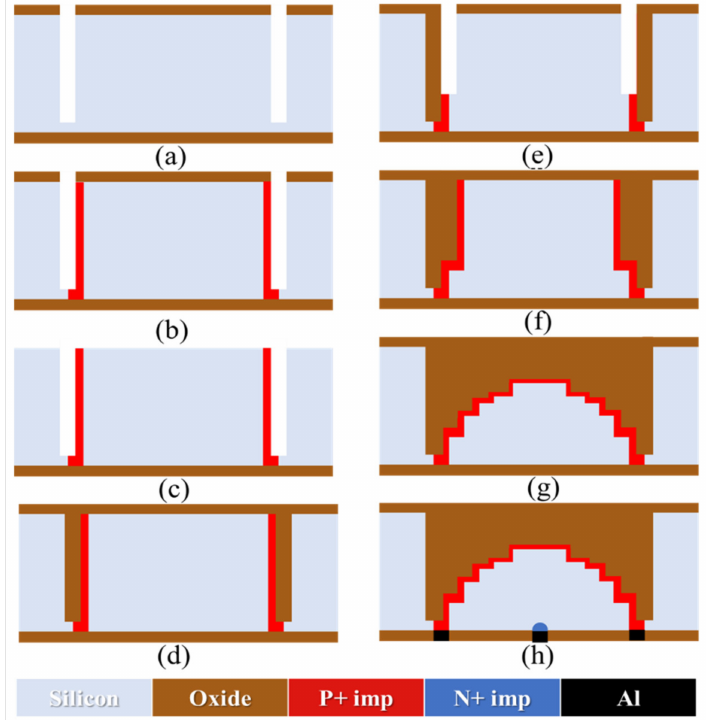
Figure 11. The proposed fabrication process of the hemispherical/near-hemispherical electrode